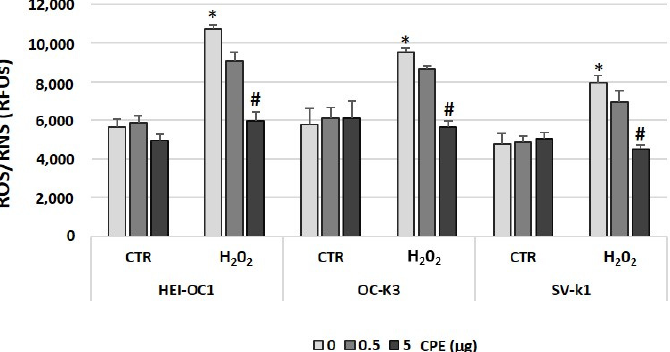
Figure 3. Cocoa modulated total ROS/RNS productions in senescence auditory cells. ROS/RNS were measured in HEI-OC1, OC-k3, and SV-k1 cells. Experimental groups: CTR group (0, 0.5 and 5 μ g/mL of CPE for 20 h) and H 2 O 2 group (induced cellular senescence with 100 μ M for 1 h in all groups: 0, 0.5 and 5 μ g/mL of CPE for 20 h). The diagrams represent the mean ± SD of relative fluorescent units (RFU). * p < 0.05 vs. CTR group; # p < 0.05 vs. H 2 O 2 group ( n = 4). red fluorescence in the nuclei of cells. The senescence cells in the H 2 O 2 group showed an augmented fluorescence compared to the non-H 2 O 2 -treated group (CTR group) (Figure 4). After treatment with CPE, fluorescence intensity decreased in the H 2 O 2 cells group, reflecting a reduction in the production of ROS but not in the treated CTR group (Figure 4).